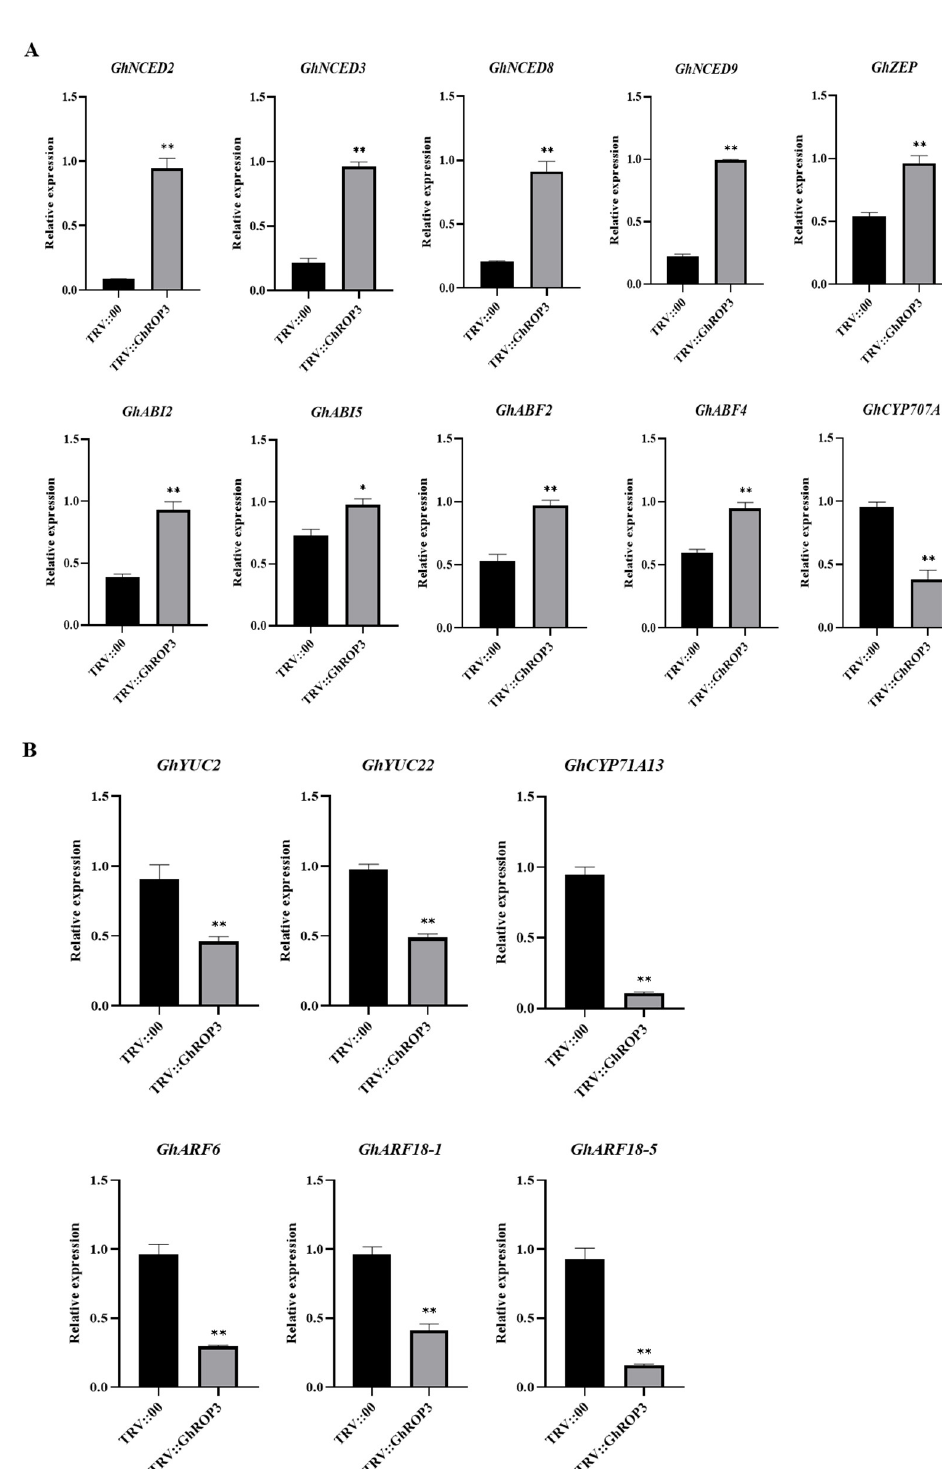
Figure 5. Analysis of the expression of genes related to ABA and IAA synthesis in true leaves of GhROP3 -silenced and negative control plants. ( A ) ABA synthesis- and signaling pathway-related genes. ( B ) IAA synthesis- and signaling pathway-related genes. Statistical analyses were performed using the Student t test. Asterisks indicate a significant difference compared with the control. *, p < 0.05; **, p < 0.01.